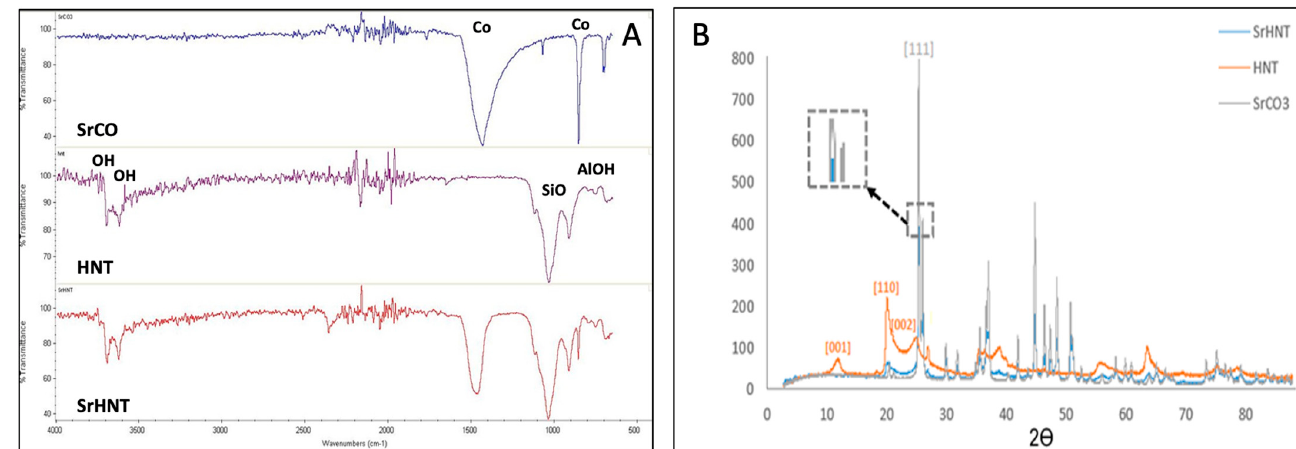
Figure 6. Elemental Analysis. ( A ) FTIR-ATR analysis of (-----) SrCO 3 (-----) HNT and (-----) SrHNT ( n = 3). ( B ) XRD graph image of HNT, SrCO 3 , and SrHNT. SrCO 3 has a strong peak at 1400 and 800 cm − 1 depicting the -CO group. The position of the carbonyl group depends on the function of the molecule. The position of the carbonyl group here is characteristic of SrCO 3 . For HNT, there is a distinct peak at 1040 cm − 1 showing the -SiO group. There is a peak at 900 cm − 1 showing the presence of the AlOH bond. Band peaks at 3100–3700 cm − 1 are caused by -OH groups. The OH bond usually appears. These peaks are distinguishing factors for recognizing HNTs. For SrHNT, there are combinations of peaks at 3100–3700 cm − 1 , 1400-800 cm − 1 , and 3600–400 cm − 1 . IR radia-